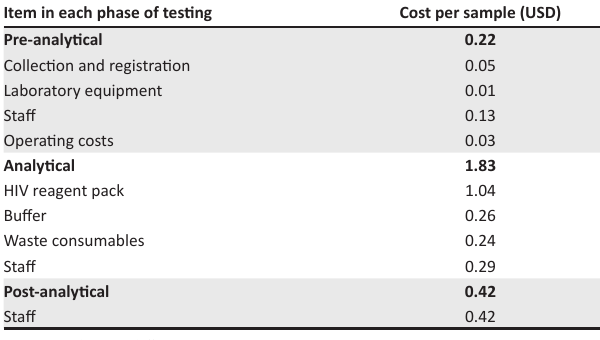
TABLE 3: Itemised cost per sample for each phase of testing for HIV serology rejections.